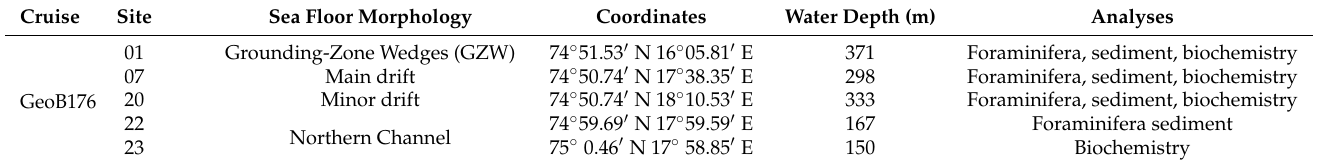
Table 1. Position data. Multiple deployments are indicated with consecutive numbers after the name of the